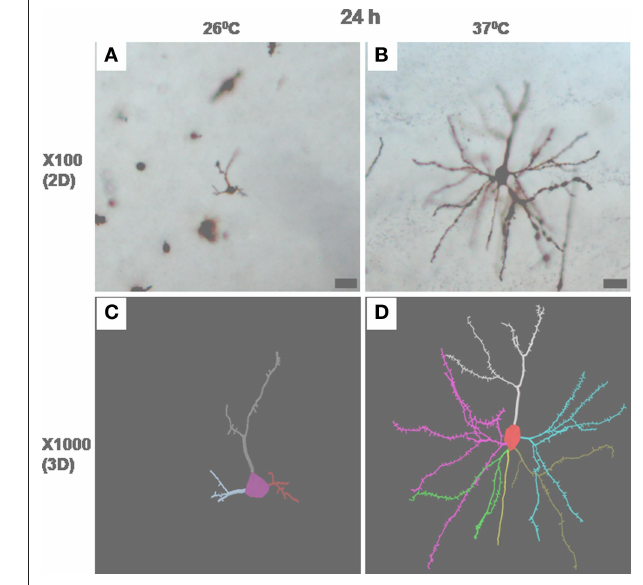
FIGure 7 | Photomicrographs in one focal plane at × 100 of stained neurons incubated at 26 ± 1 ° C (A) and 37 ± 1 ° C (B) for 24 h are shown. Several such traces taken in different planes have been reconstructed automatically by Neurolucida 9 and Neurolucida Explorer 9 and are shown in (C) and (D) as 3-D solid images. Magnified view of neuron in (A) and (B) are shown in (C) and (D) , respectively. Scale bar = 25